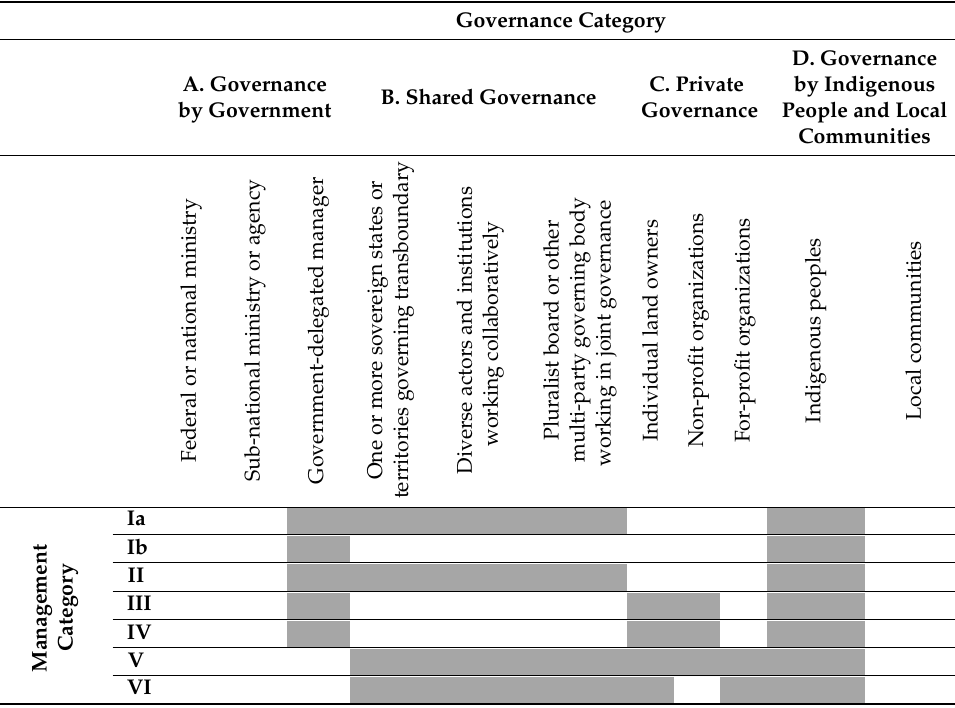
Table 7. IUCN Protected Area Matrix. Light grey cells indicate key opportunities for expansion of Canada’s PA systems. Source: Adapted from IUCN